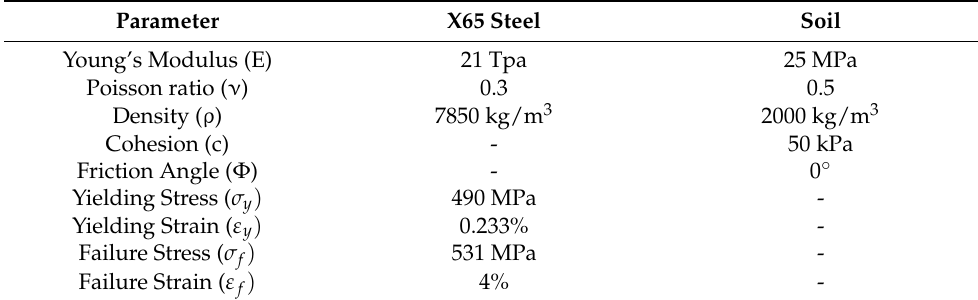
Table 1. Steel and soil properties.